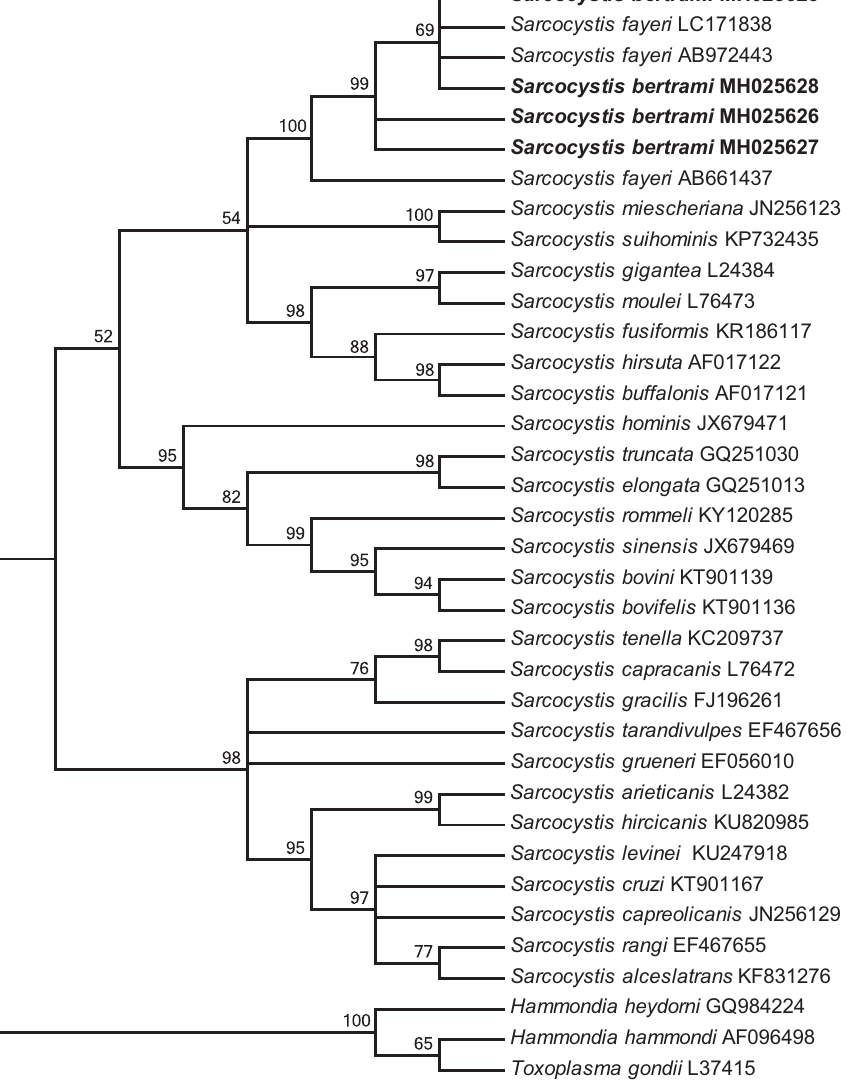
Figure 2. Phylogenetic tree based on 18S rDNA sequences. The tree was built using the maximum parsimony method with the Tree- Bisection-Regrafting algorithm. The analysis involved 36 nucleotide sequences (GenBank accession numbers behind the taxon names) and a total of 1258 positions in the fi nal dataset. The values between the branches represent bootstrap values per 1000 replicates, and values below 50% are not shown. The four new sequences of Sarcocystis bertrami (MH025625 – MH025628, shown in boldface) formed a clade with S . fayeri from horses, and the clade was within a group comprising Sarcocystis spp. from ruminants and